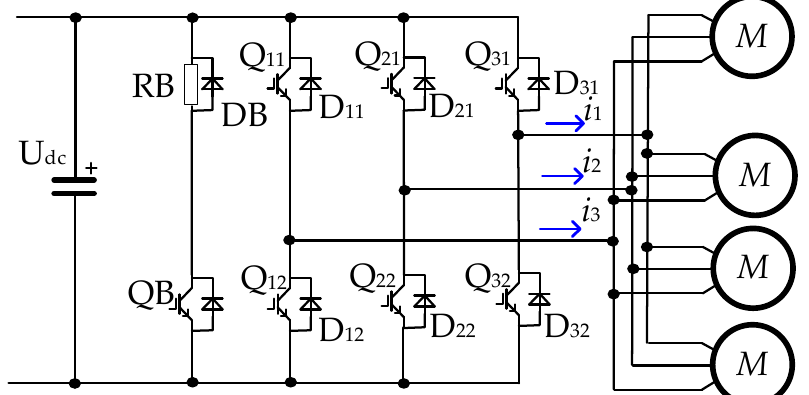
Figure 6. TC (traction converter) circuit topology.